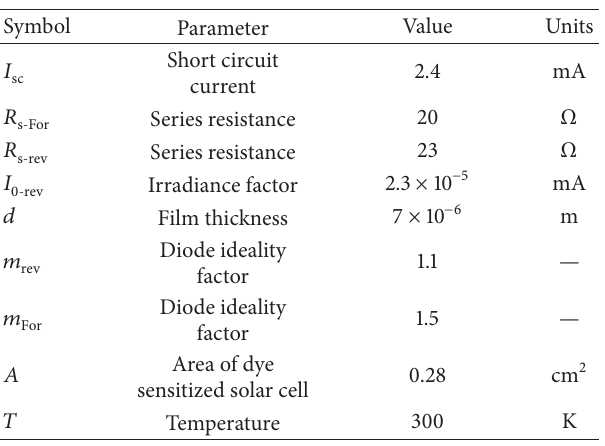
Table 3: Best fitting parameters and experimental values to fit experimental data to (8).